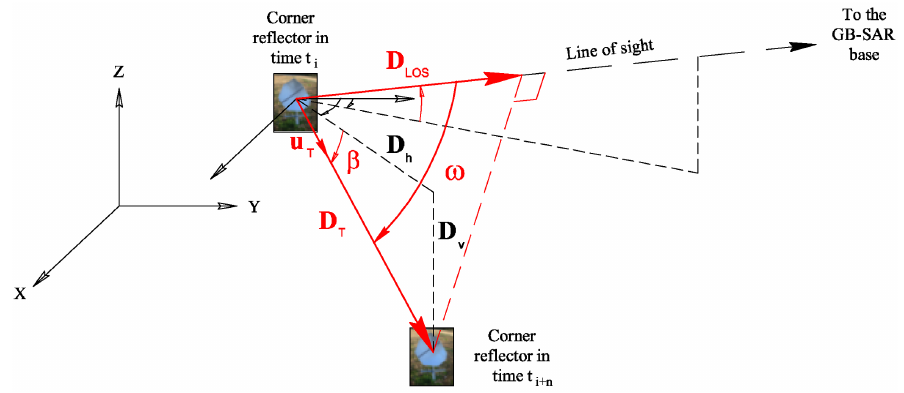
Fig. 9. Estimation of the total displacement ( D T ) projecting the LOS displacement vector ( D LOS ) of the GB-SAR data onto the total displacement unitary vector ( u T